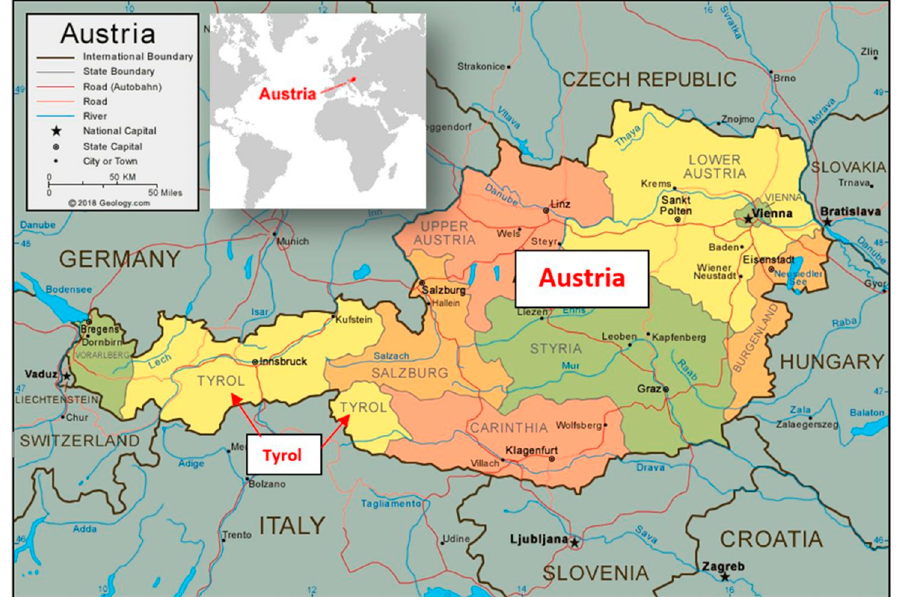
Figure 1. Study area. Maps of the study area Tyrol, which is located in Austria (47 ◦ 41 (cid:48) 47.30 (cid:48)(cid:48) N, 13 ◦ 20 (cid:48) 44.64 (cid:48)(cid:48) E), Central Europe. The map was taken from https://geology.com/world/austria- satellite-image.shtml (accessed 6 March